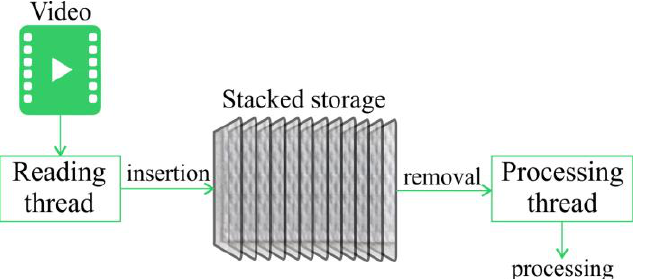
Figure A1. Representation of the processing steps in the multi-threading feature of